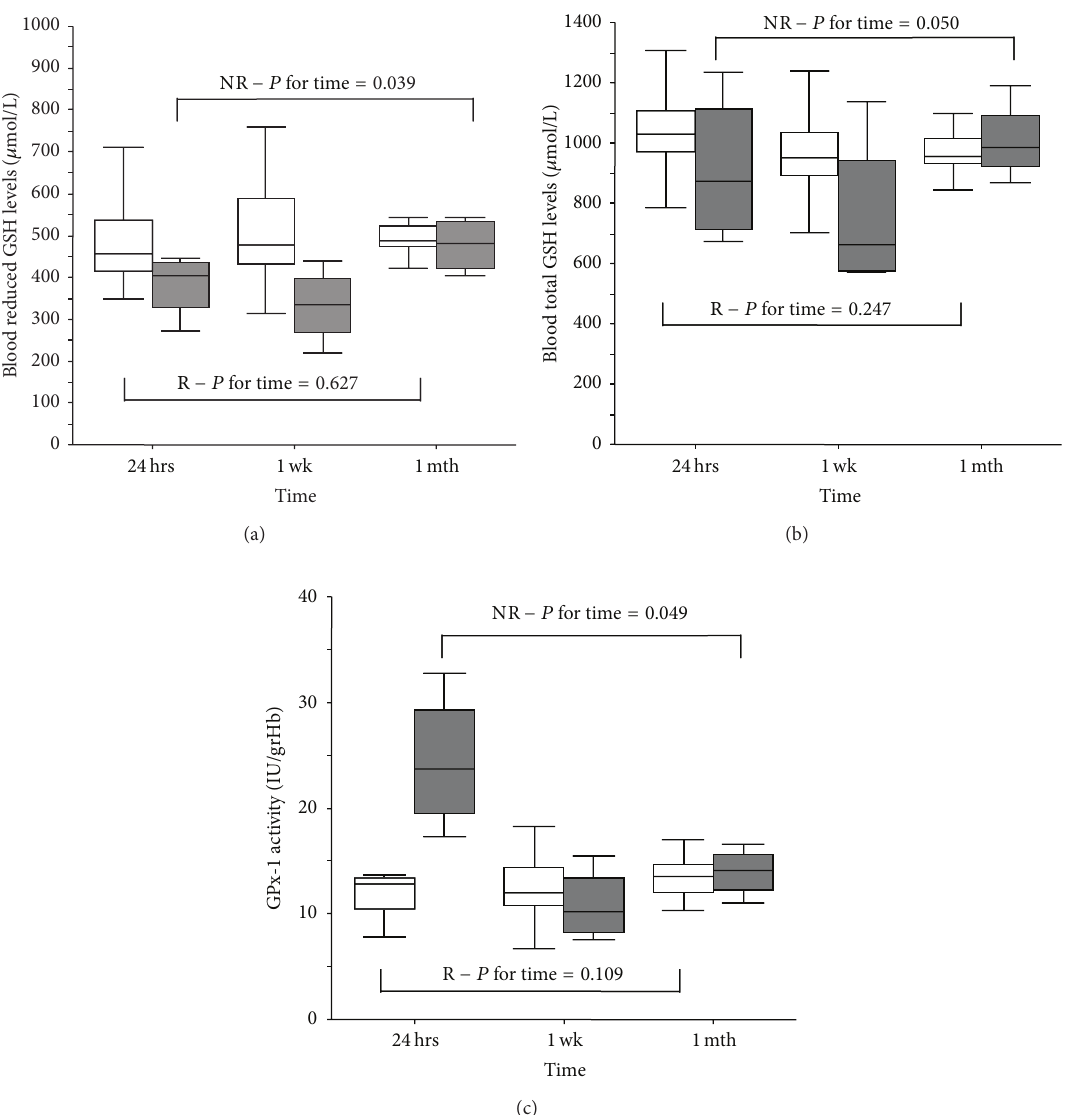
Figure 3: Profile of levels of blood reduced GSH (a), blood total GSH (b), and GPx-1 activities (c) in NR and R patients (R: empty box-plots; NR: dark box-plots). 𝑃 for time refers to time-dependent changes (24 hours, 1 week, and 1 month) in groups assessed by nonparametric Friedman